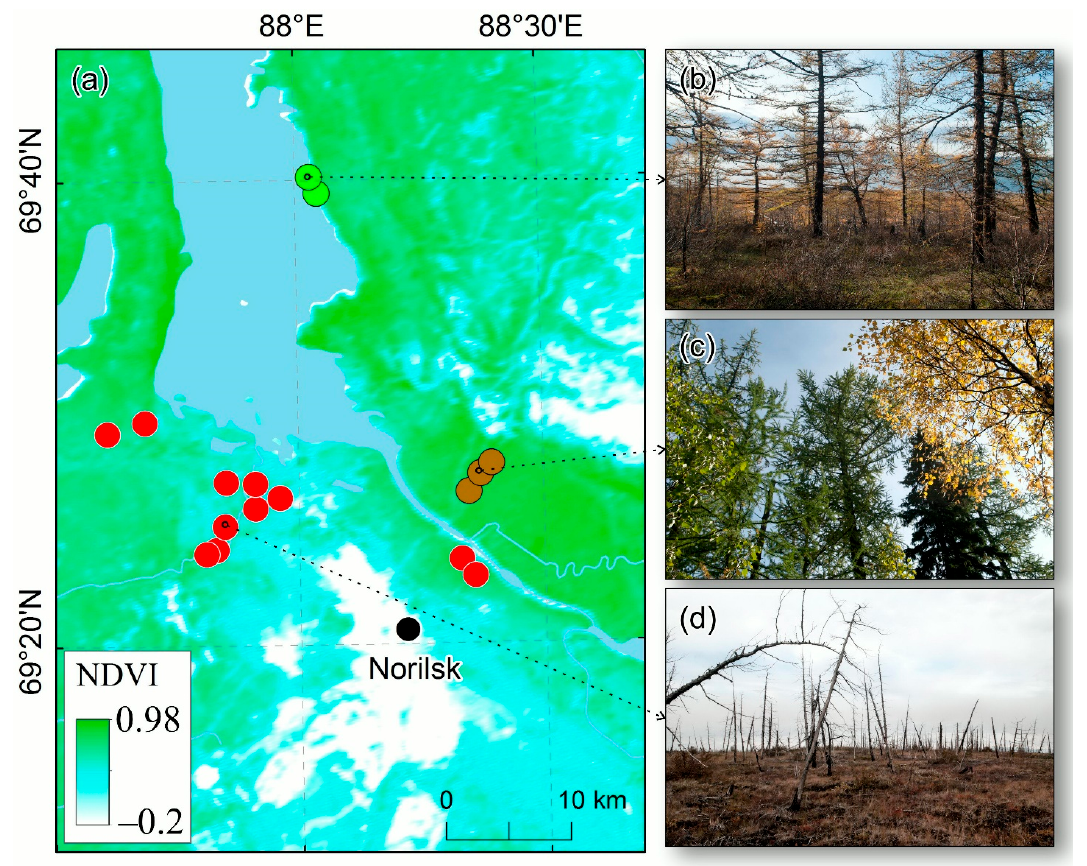
Figure 2. Study area and test plot (TP) location ( a ). TPs in the “impact zone” (area of severe damage and mortality) are indicated by red dots. Brown dots indicate TPs in the mixed larch, spruce, and birch stands, or “LSB zone”. Reference plots are shown in green. ( b ) Larch trees in refence plot, ( c ) mixed larch-spruce-birch forest in the LSB zone, ( d ) dead larches in impact zone. Table 1. Description of test plots.